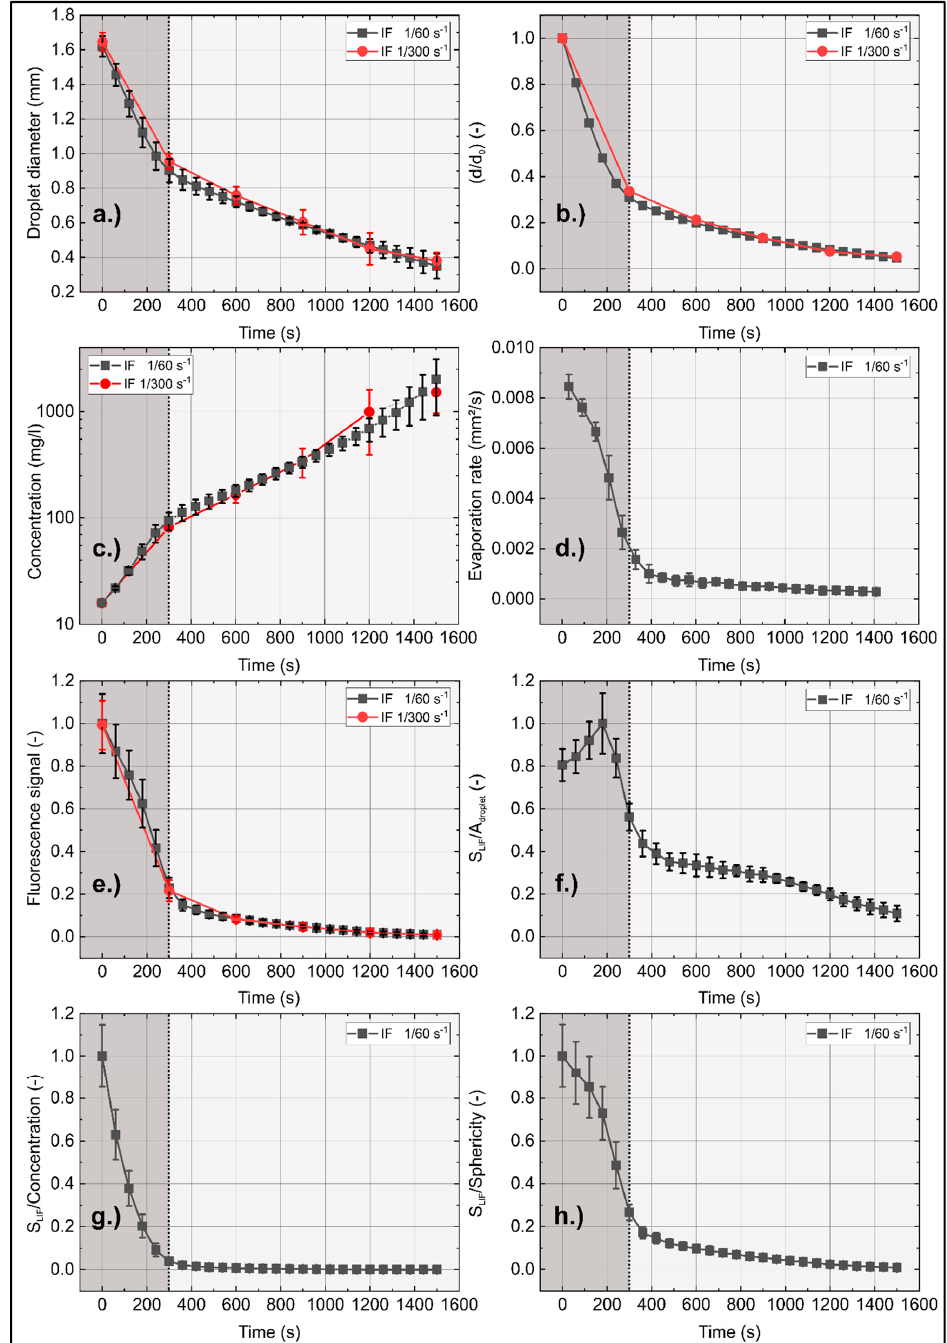
Figure 13. Time dependent averaged droplet diameter ( a ), (d/d 0 ) 2 behavior ( b ), dye concentration ( c ), evaporation rate (( d ); d(d 2 )/dt), droplet fluorescence signal (( e ), normalized droplet fluorescence signal to droplet area ( f ), normalized to concentration ( g ), and normalized to sphericity ( h )), 293 K initial temperature. Two stage evaporation marked in gray (dark gray: first stage, light gray: second stage).